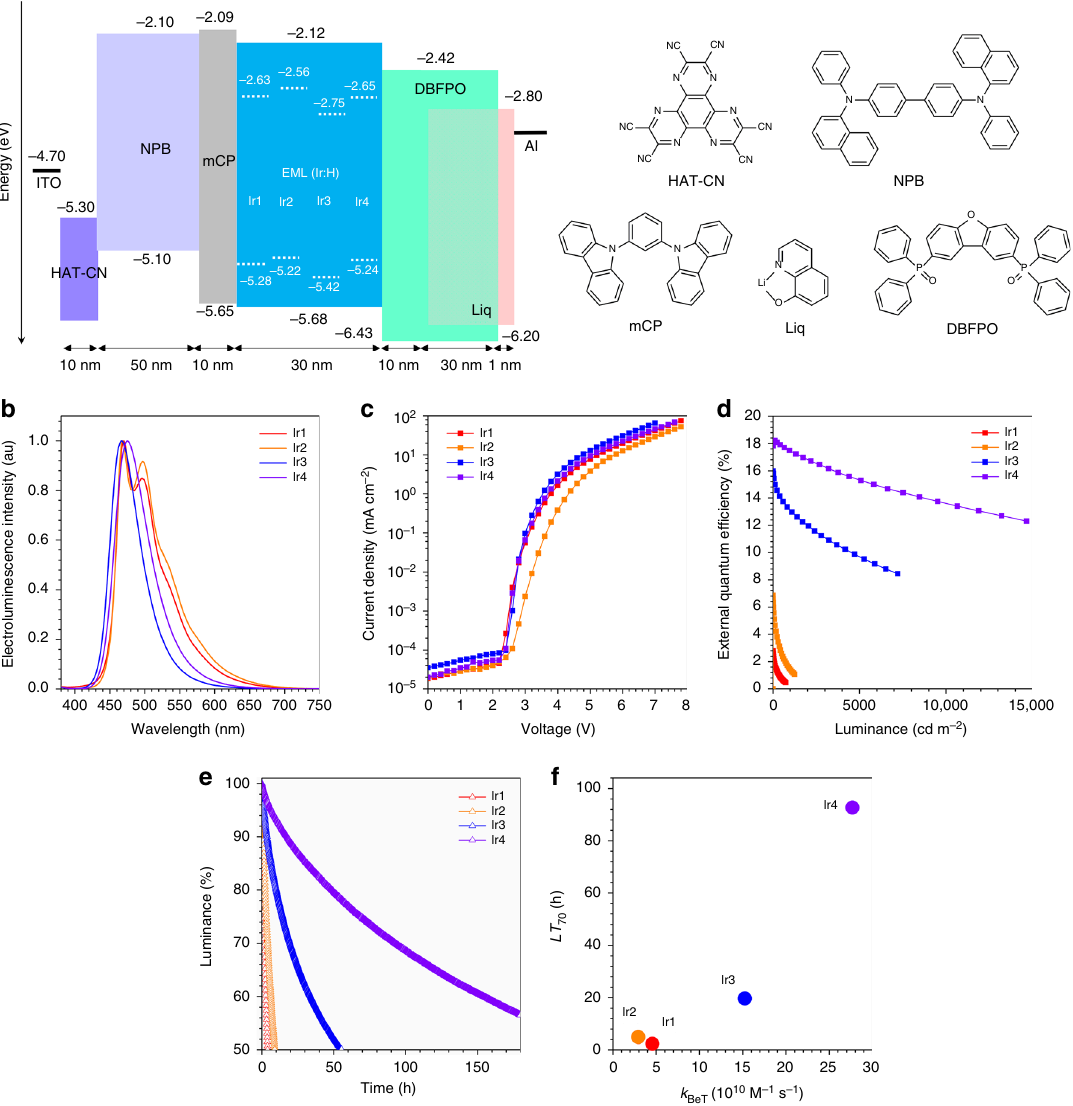
Fig. 6 Device performance. a Schematic diagram of the con fi guration of the electroluminescence devices tested, including the energy levels of their component materials. b Electroluminescence spectra. c Current density – voltage curves. d External quantum ef fi ciencies as a function of luminance. e Luminance decays during operation of the devices in a constant current driving mode. f Correlation between the operation lifetime ( LT 70 ) of the devices and the rate constant for back electron transfer ( k BeT